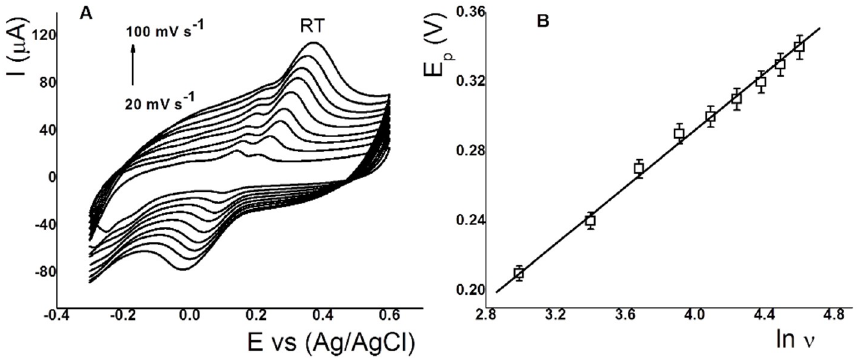
Figure 4. ( A ) Voltammograms and ( B ) plots of the dependence of anodic peak potentials vs. ln ν for RT (35.0 μmol L –1 ) using IL‐CS/SPC electrode. RT (35.0 µ mol L − 1 ) using IL-CS/SPC